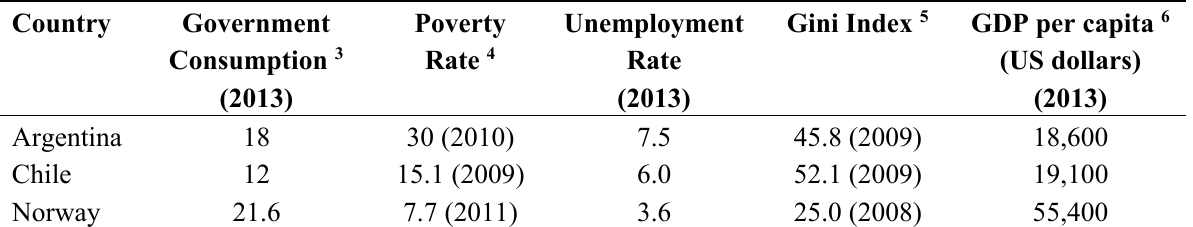
Table 1. Some indicators of the economic situation in Argentina, Chile and